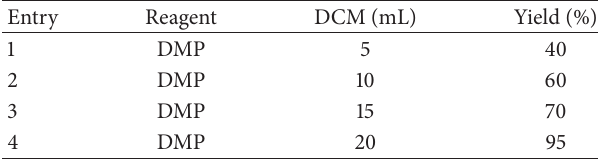
Table 1: Solvent volume optimization.